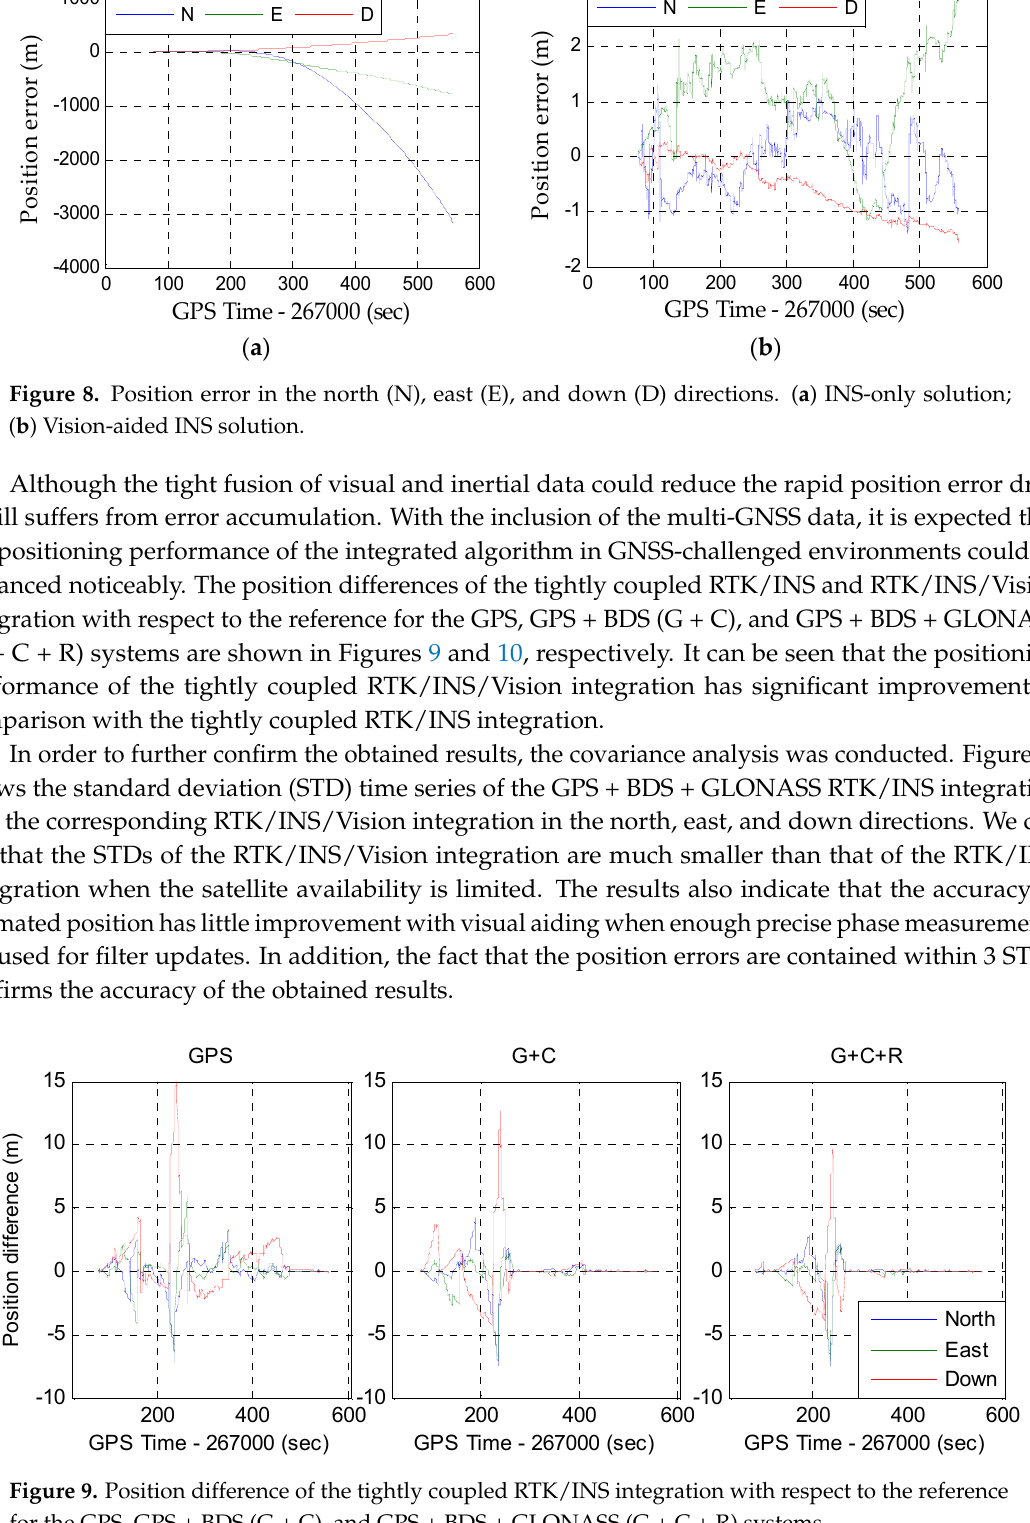
Figure 10. Position difference of the tightly coupled RTK/INS/Vision integration with respect to the reference for the GPS, GPS + BDS (G + C), and GPS + BDS + GLONASS (G + C + R) systems.